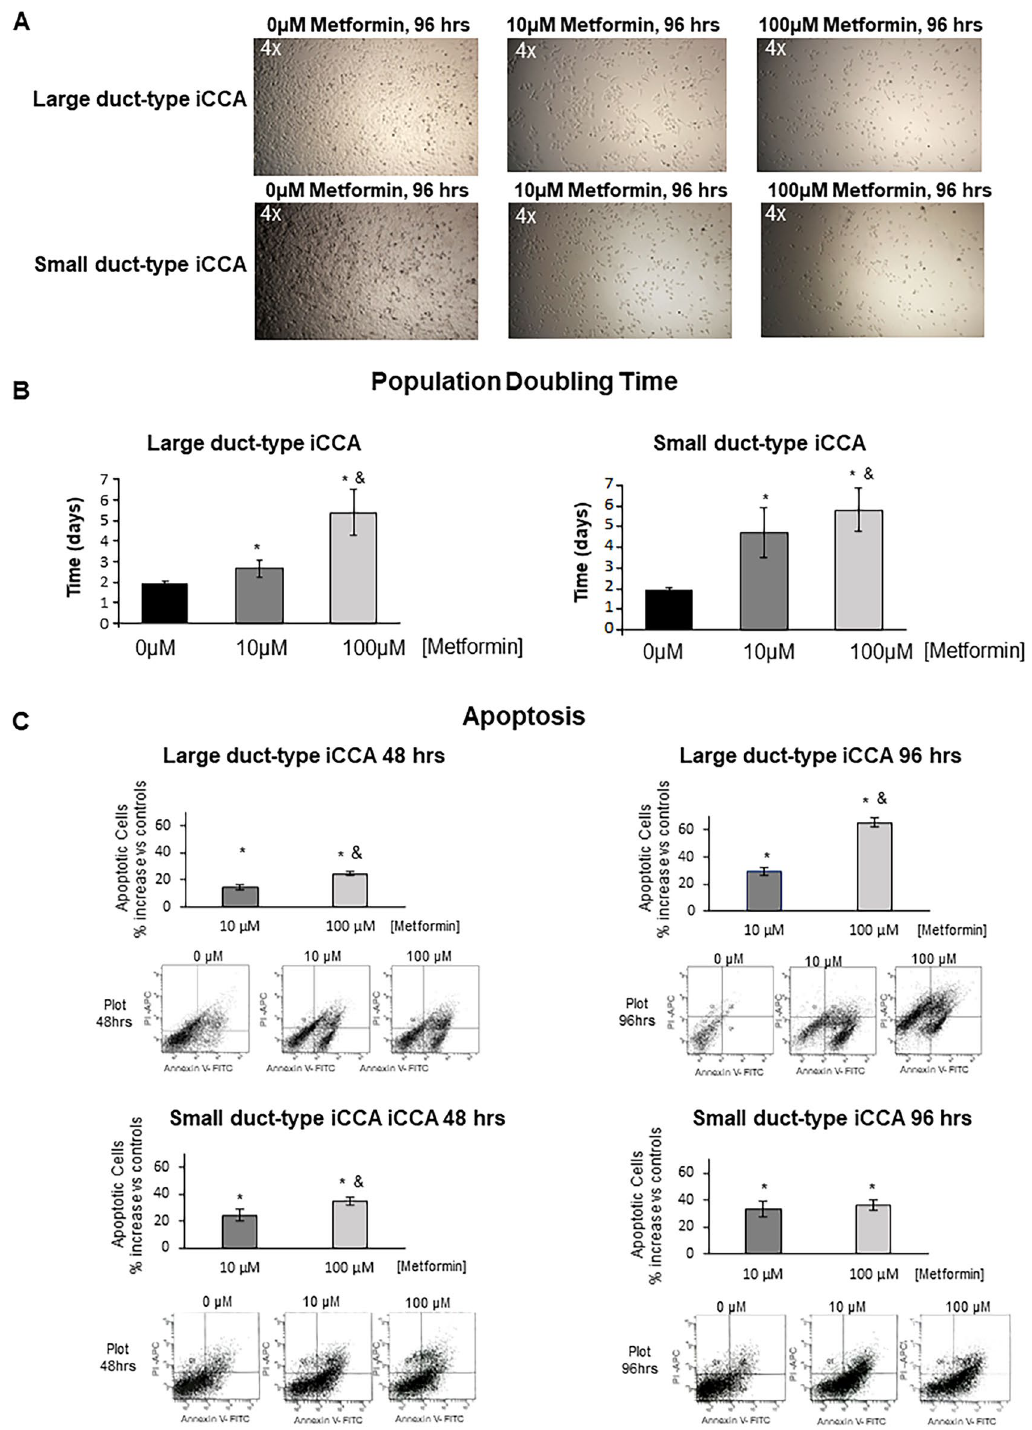
Figure 2. Effect of Metformin on cell density, population doubling time (PDT) and apoptosis of primary iCCA cell cultures. ( A ) Optical microscopy pictures of primary cultures of Large and Small duct-type iCCA exposed to Metformin 10 µM or 100 µM for 96 h; the decreased cell density (vs controls) is clearly evident. Data represent N = 5 independent experiments. ( B ) PDT was calculated as the time (days) required by cell cultures to duplicate their cell number. Metformin markedly elongated the PDT. Data represent mean ± SD of N = 5 independent experiments. * p < 0.05 versus controls. & p < 0.05 versus 10 µM. ( C ) Apoptosis was assessed in both Large and Small duct-type iCCA primary cell cultures by Annexin-V/PI assay. The percentage of apoptotic cells significantly increased after treatment for 48 or 96 h with Metformin 10 µM or 100 µM. Data represent mean ± SD of N = 5 independent experiments; * p < 0.05 versus controls; & p < 0.05 versus 10